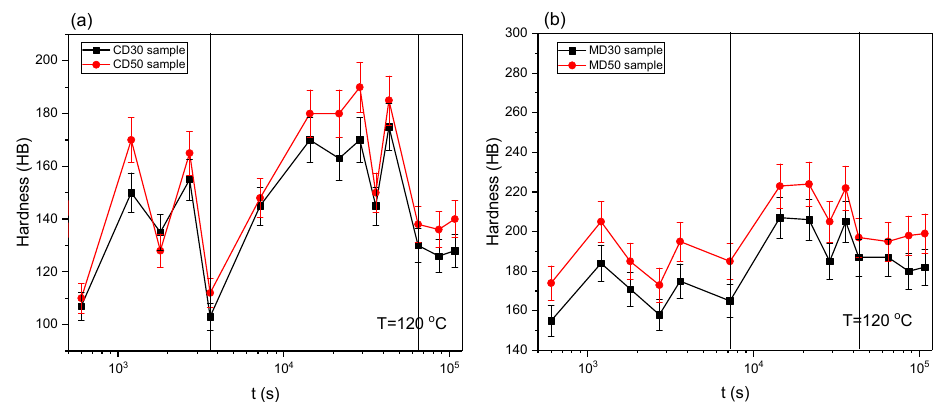
Figure 3. The effect of ageing time on the hardness of alloys in thermomechanical treatments with: ( a ) conventional dissolution, and ( b ) modified quenching.